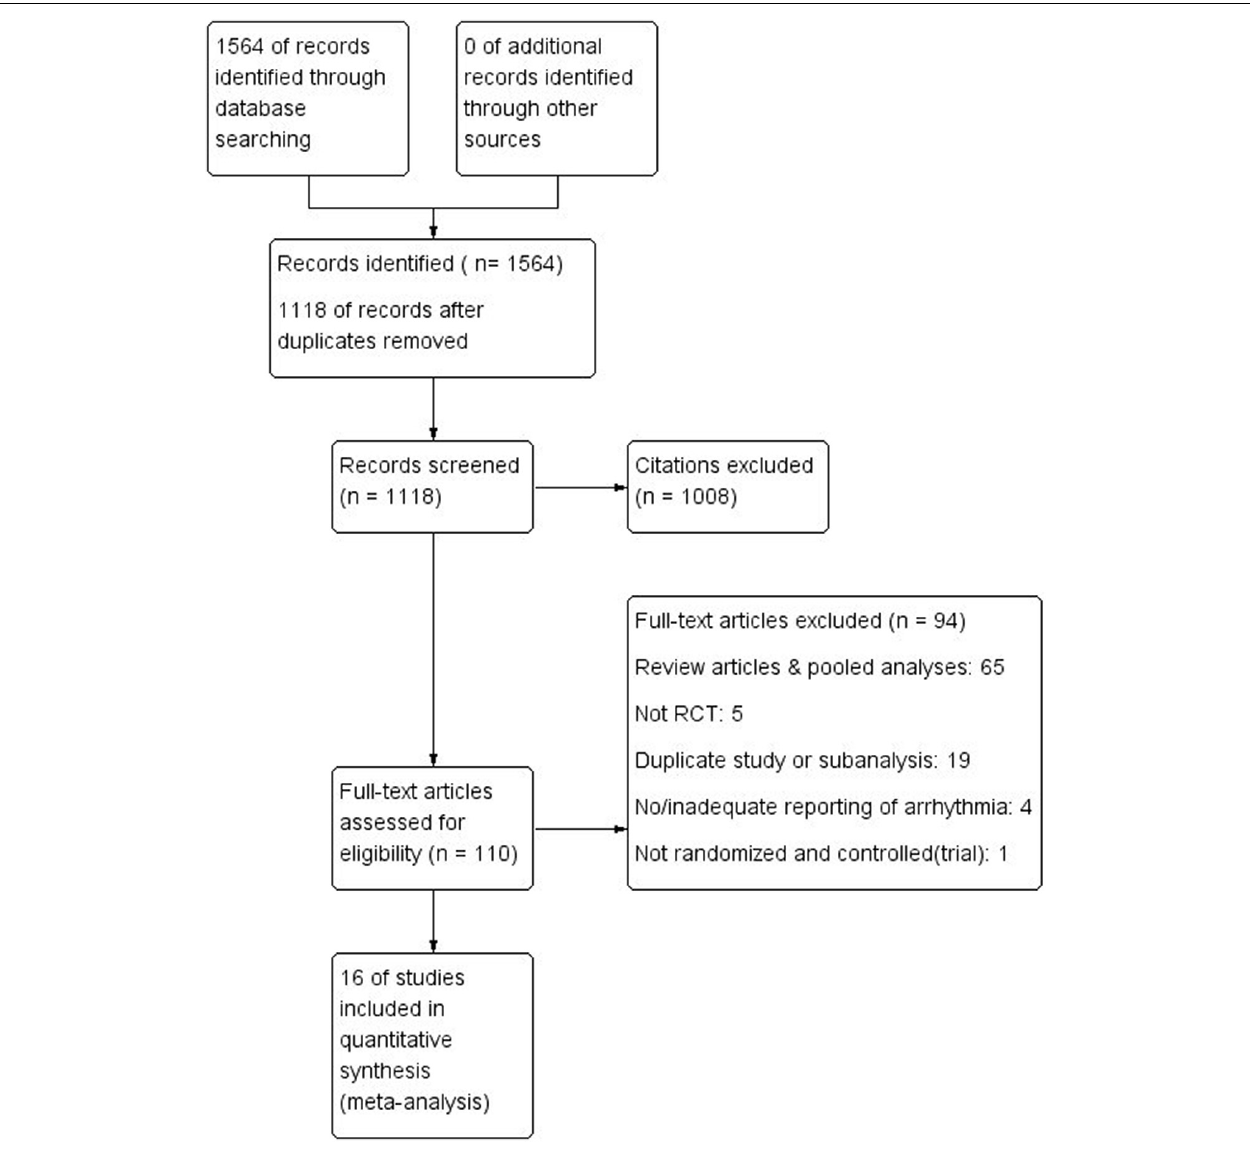
FIGURE 1 | Study flow